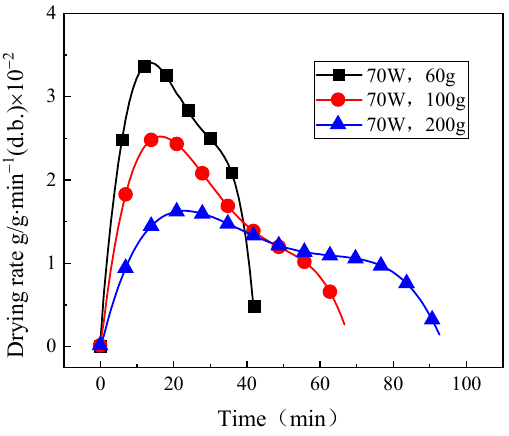
Figure 6. Microwave drying rate of corn with different loads.